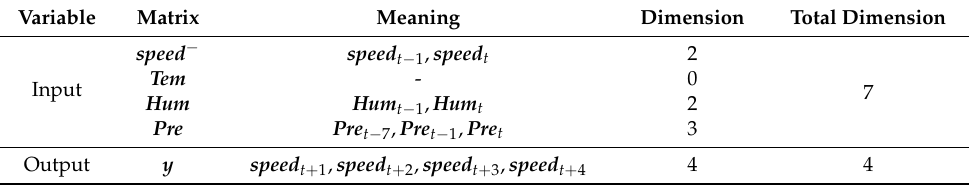
Table 2. Dimensions of the input and output variables after the selection of the input